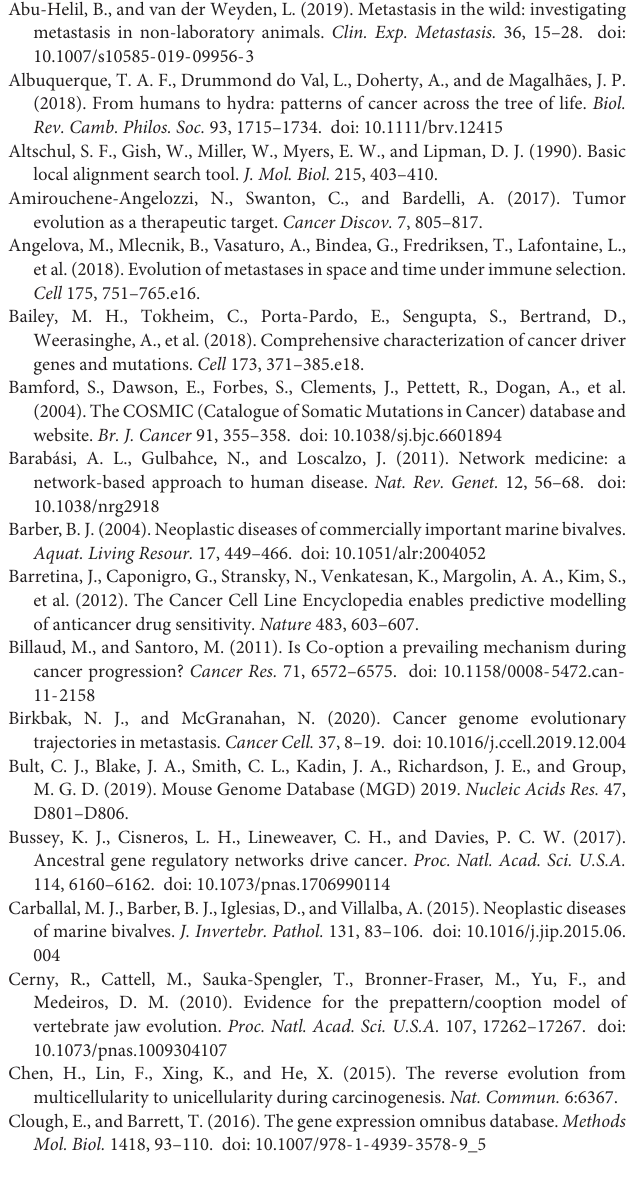
Supplementary Table 4 | JIGs and their effect on patient survival prognosis across different cancer types of TCGA based on Cox regression analysis. Annotations: poor prognosis = 1, favorable prognosis = -1, insignificant = 0. Supplementary Table 5 | JIG orthologs across pre-gnathostome and gnathostome species. Annotations: green = pregnathostome orthologs, orange: gnathostome-specific orthologs, underlined = network hubs. Supplementary Table 6 | Comprehensive overview of the preclinical and clinical research studies on the hub JIGs that are deregulated in highly- invasive cell lines of CCLE. The drivers of tumor progression predicted using the key innovation-driven model are in agreement with existing experimental